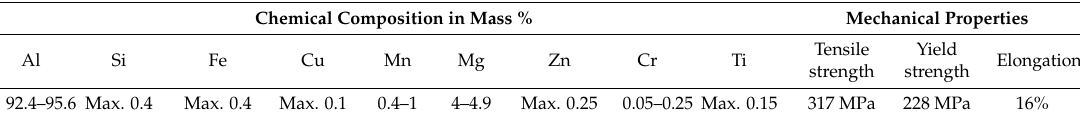
Figure 2. Geometric characteristics of the micro end mill.